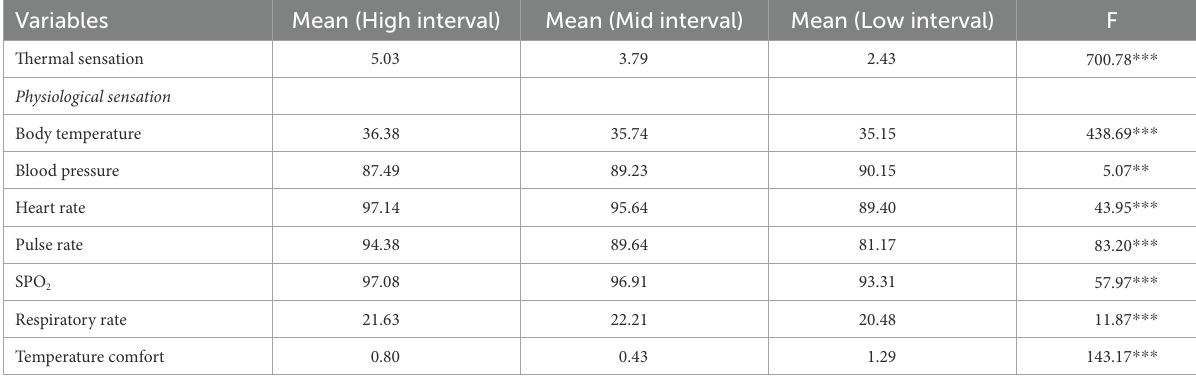
TABLE 3 Main effects of environmental temperature conditions.